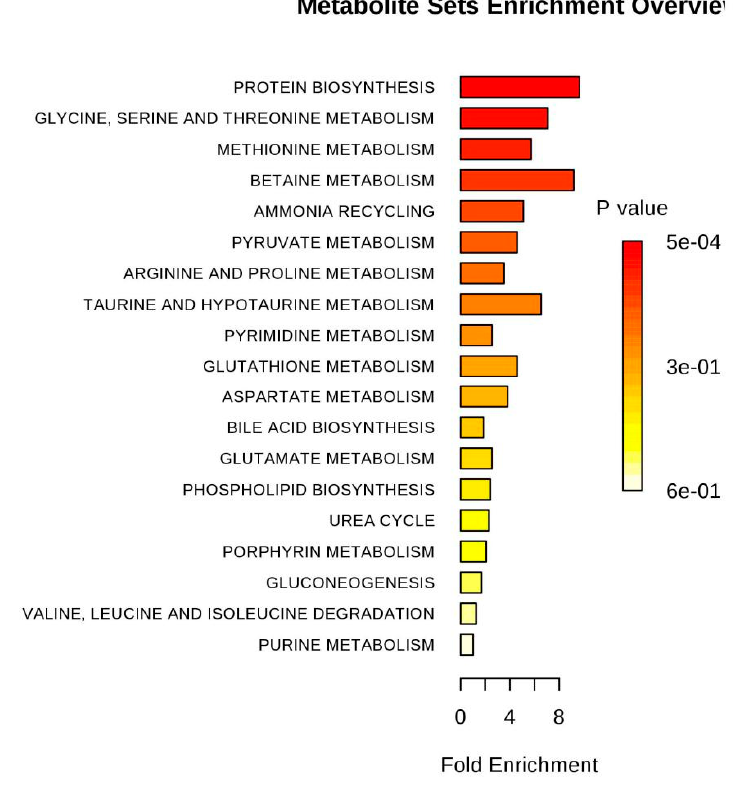
Figure 11. The pathway analysis of all differential metabolites between SPPM60-D and control groups.